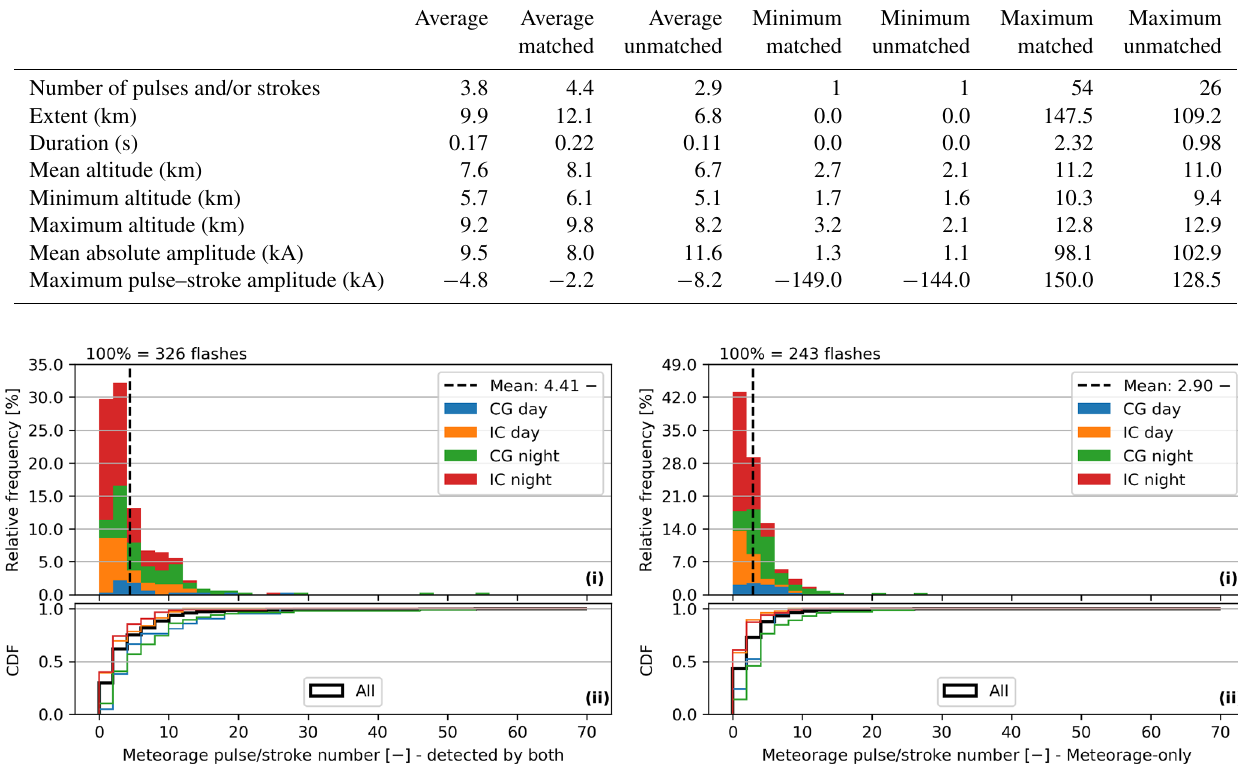
Table 3. Overall average and the average, minimum and maximum values of Meteorage flash characteristics for matched and unmatched flashes. The minimum (maximum) altitude represents the 10th (90th) percentile of concurrent SAETTA sources. The maximum pulse–stroke amplitude is the maximum current observed for the flash (negative or positive).